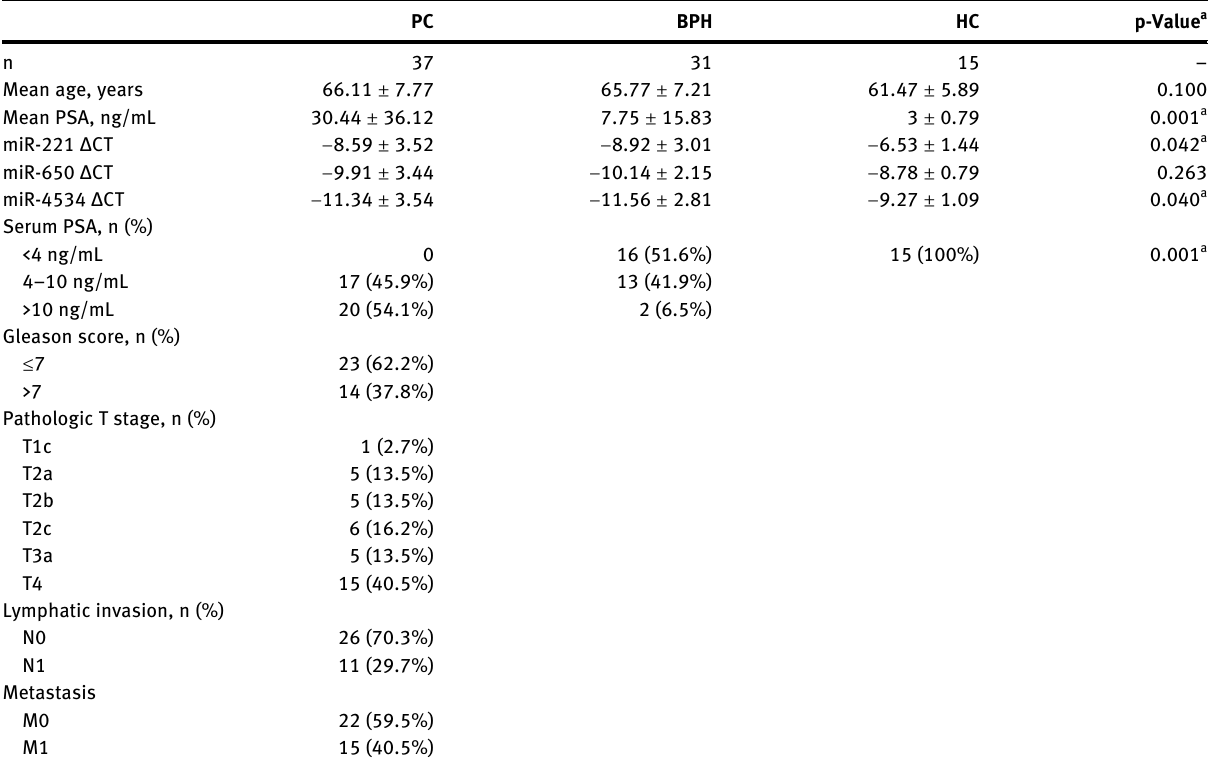
Table  : Clinicopathological features and characteristics of the study